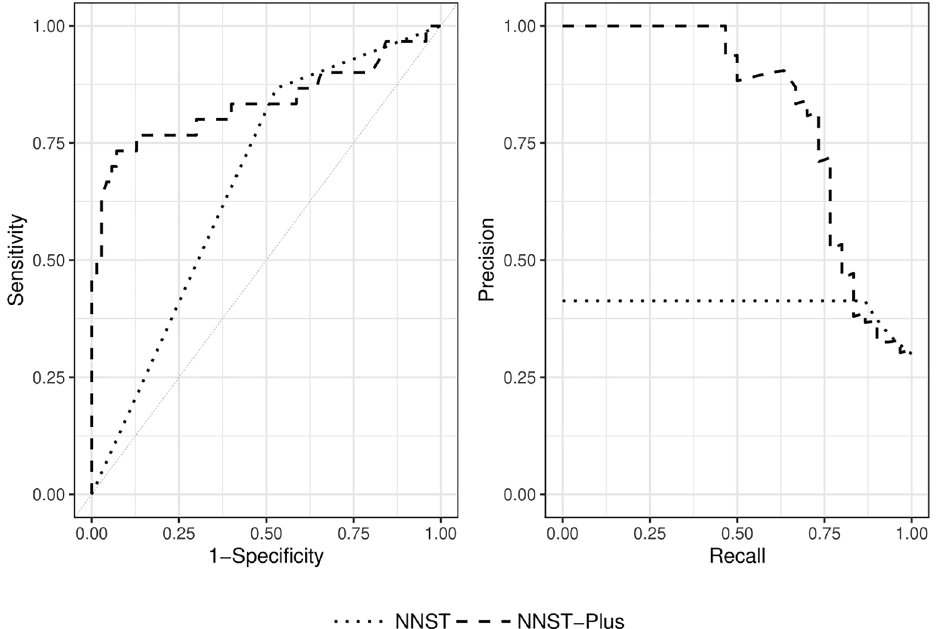
Figure 4. Receiver operating characteristic (ROC) curve and Precision-recall (PR) curve for weight gain at discharge classification based on NNST and NNST-plus